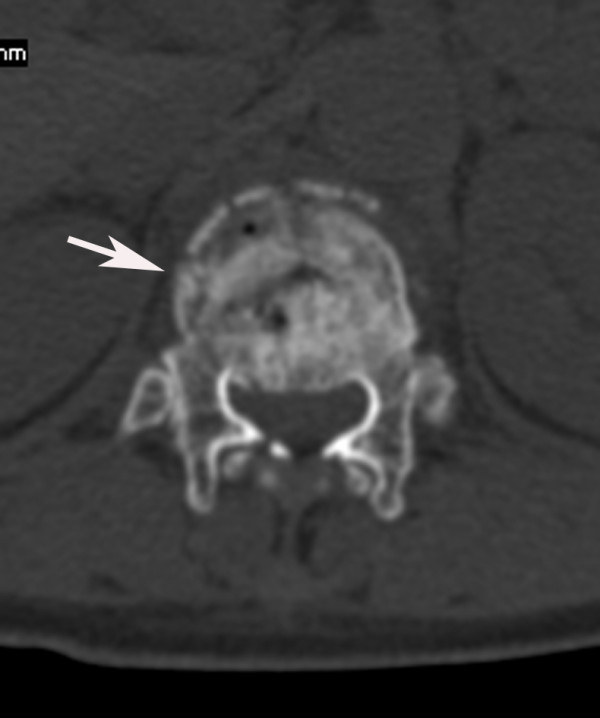
Cross-sectional image of the same patient as in Figure 1 clearly shows the associated burst fracture (type A3) of T12 (arrow) and the spinal canal narrowing degree of 1 (constriction of one third of the spinal canal).